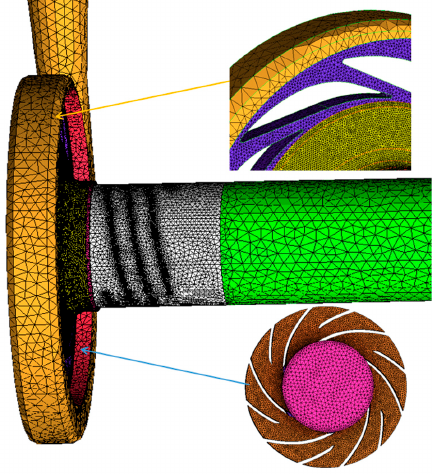
Figure 6. Computational domain grid schematic.